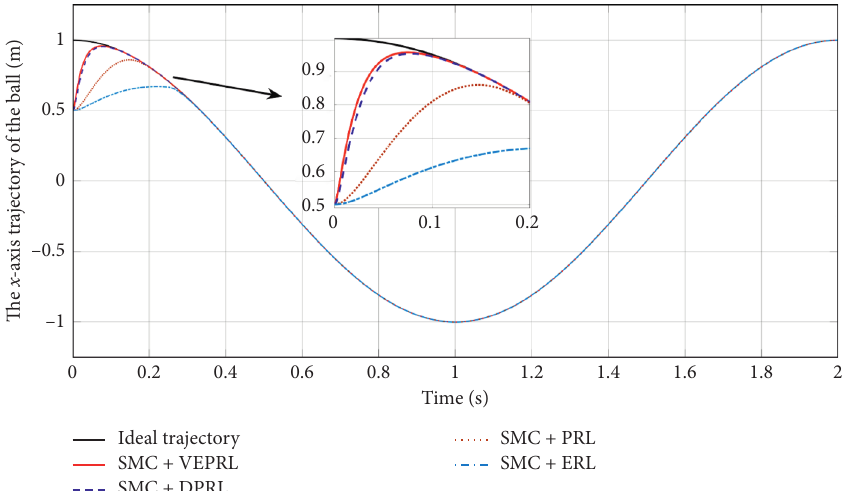
Figure 5: Comparison of x -axis tracking trajectory of the ball and plate system under